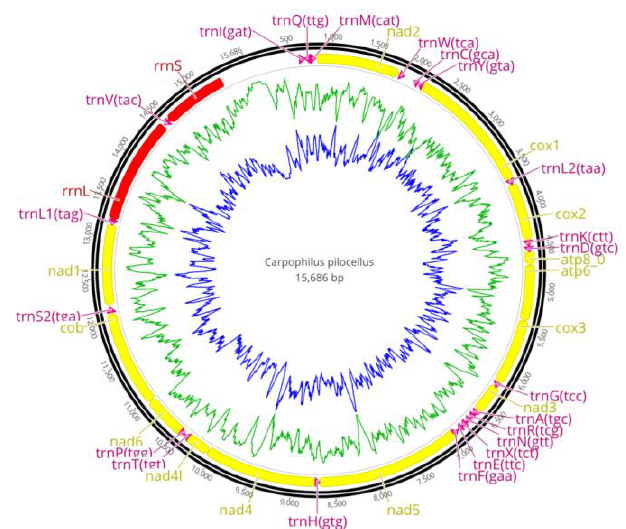
Figure 1. The mitochondrial genome arrangements of C. dimidiatus and C. pilosellus . The yellow is protein-coding genes (PCGs), the red is rRNA genes, and the purple is transfer RNA (tRNA) genes. The AT content and GC content were plotted using a blue and green sliding window, respectively, as the deviation from the average AT content and GC content of the entire sequence. Table 1. Annotation of the mitochondrial genome of Carpophilus dimidiatus and Carpophilus pilosellus . Gene